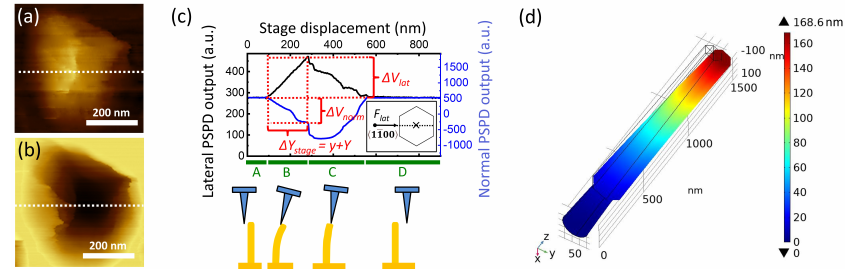
Figure 6. Typical bending curves ( c ) extracted from selected areas of V lat ( a ) and V norm ( b ) maps (B4 in Figure 5). White dashed lines in ( a , b ) show the selected lines corresponding to the maximal NW deflection. Calculated deformation for the same NW (B4) using Comsol FEA at maximal loading force right before the AFM tip-NW separation ( d ). The projection of the linear region (Figure 6c, B) of the V lat curve on the horizontal axis, that is, the AFM stage movement ( ∆ Y stage ), included both the maximal NW deflection ( y ) and lateral tip displacement ( Y ), whereas the projection on the corresponding vertical axis provided the maximal change of the lateral PSPD output during the bending ( ∆ V lat